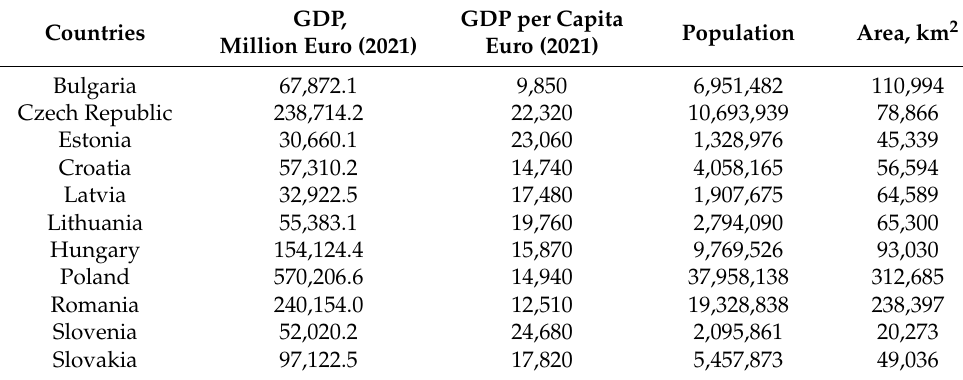
Table 2. Basic demographic, economic and geographical information about the CEE countries (own elaboration based on [17]).